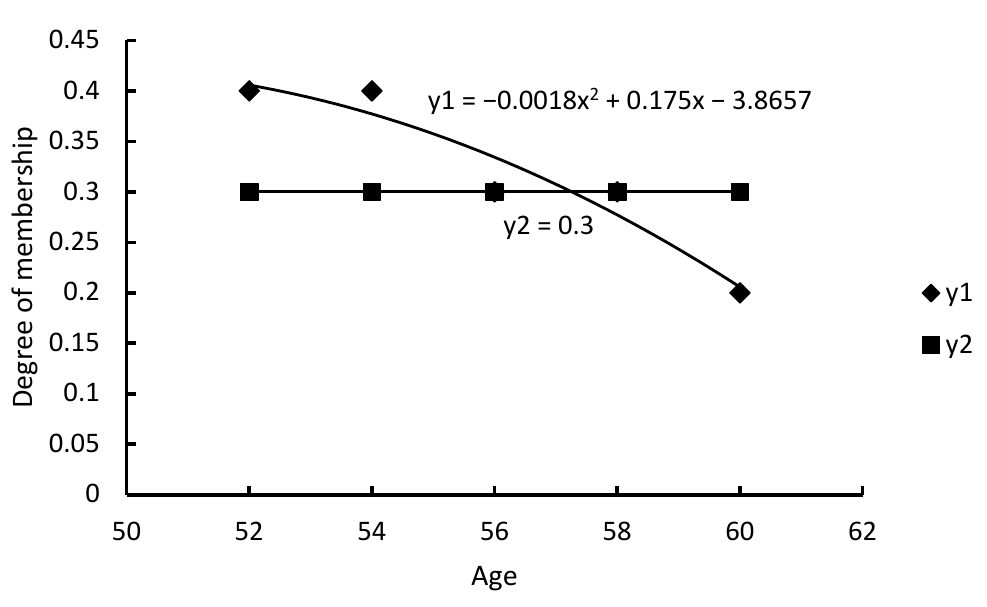
Figure 4. Single factor evaluation for 31–50 years old.